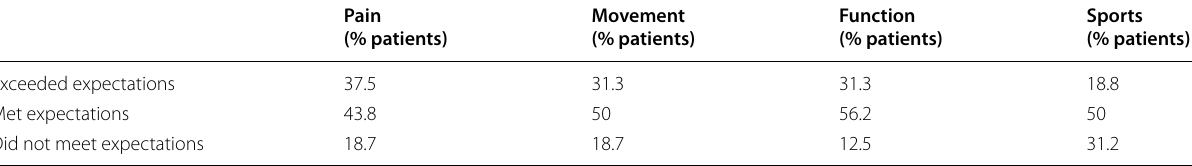
Table 1 Overall satisfaction of patients at 2-year follow-up